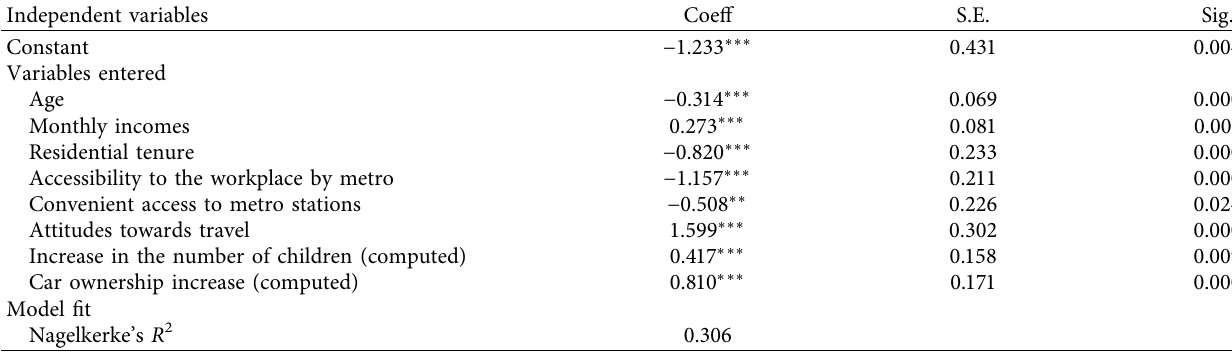
Table 5: Logistic regression analysis results related to changes in sustainable transport users’ travel behaviour. Independent